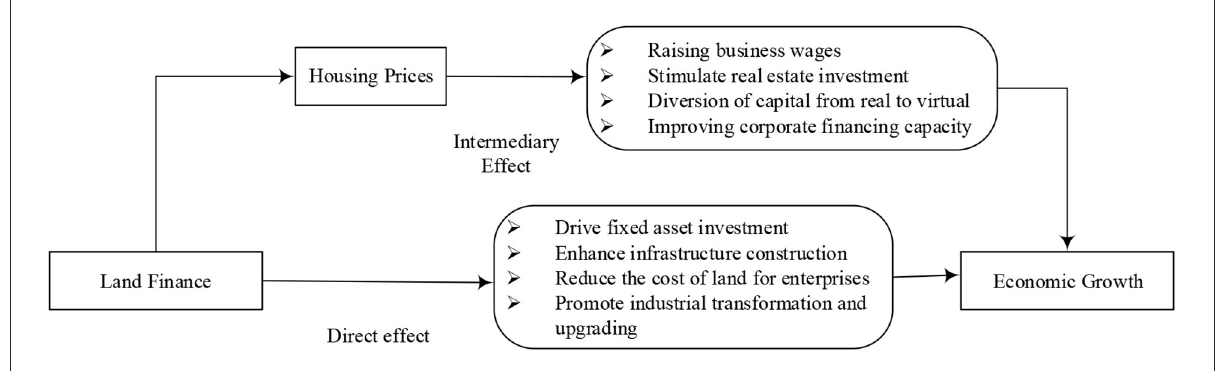
FIGURE1 The theoretical model of land finance, housing price, and economic